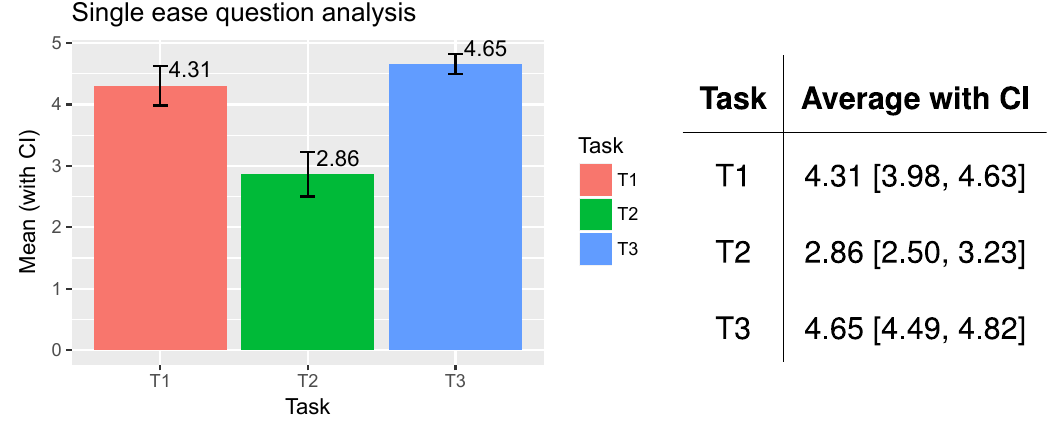
Figure 6: SEQ analysis. Audiometry (T1) and questionnaires (T3) are easy to perform. Acufenometry (T2) is difficult to perform.